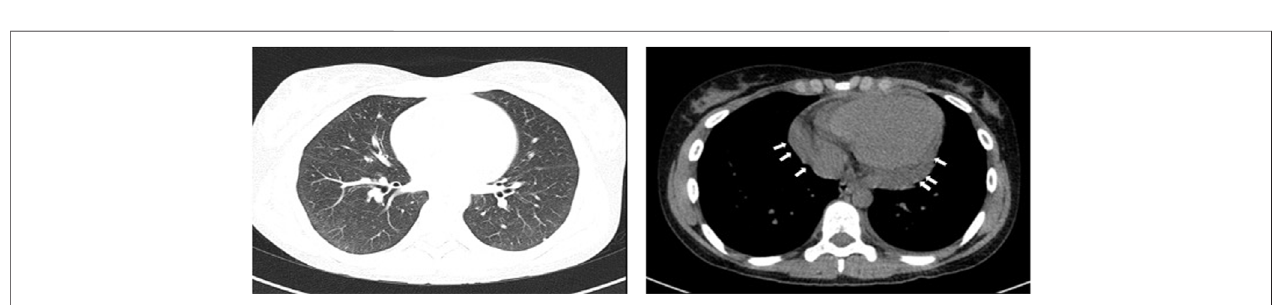
FIGURE 2 | Thorax CT scan shows interstitial lung thickening with peripheral opacities. Thorax CT scan shows small pericardial effusion, as indicated by white arrows.